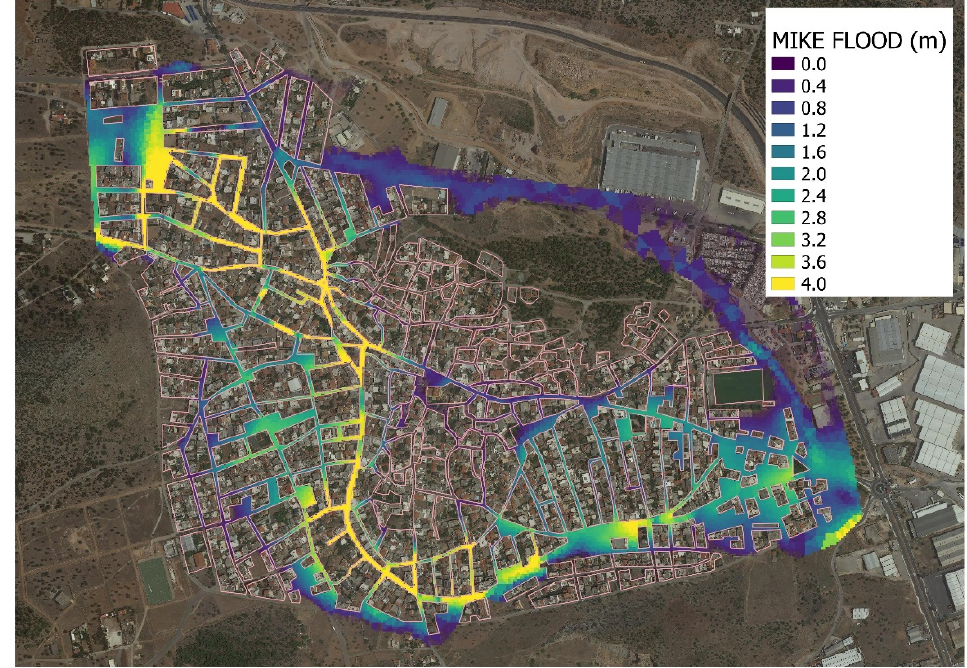
Figure 14. Results of the informed MIKE FLOOD for maximum water depths.